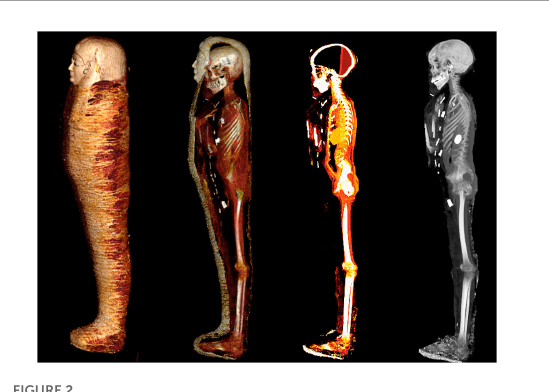
FIGURE2 Digital unwrapping visualizations using computed tomography (CT) of the mummy TR 21/11/16/16 at the Cairo Egyptian Museum. A series of four three-dimensional (3D) CT images of the mummy in the left lateral position show the steps of the virtual peeling of the bandages from left to right: the outer surface of the wrapped mummy (far left); partial unwrapping reveals the mummy within the bandages; the totally unwrapped mummy is viewed with a CT window level that highlights the soft tissues and embalming materials; the totally unwrapped mummy is viewed with a CT window level that shows the skeleton and dense amulets related to the mummy (far